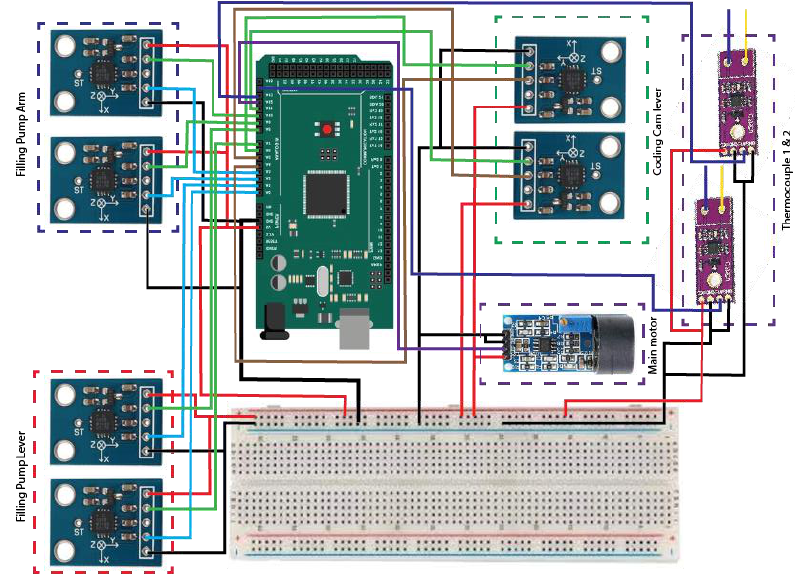
Figure 6. Electrical connections on the sensors and microcontroller.